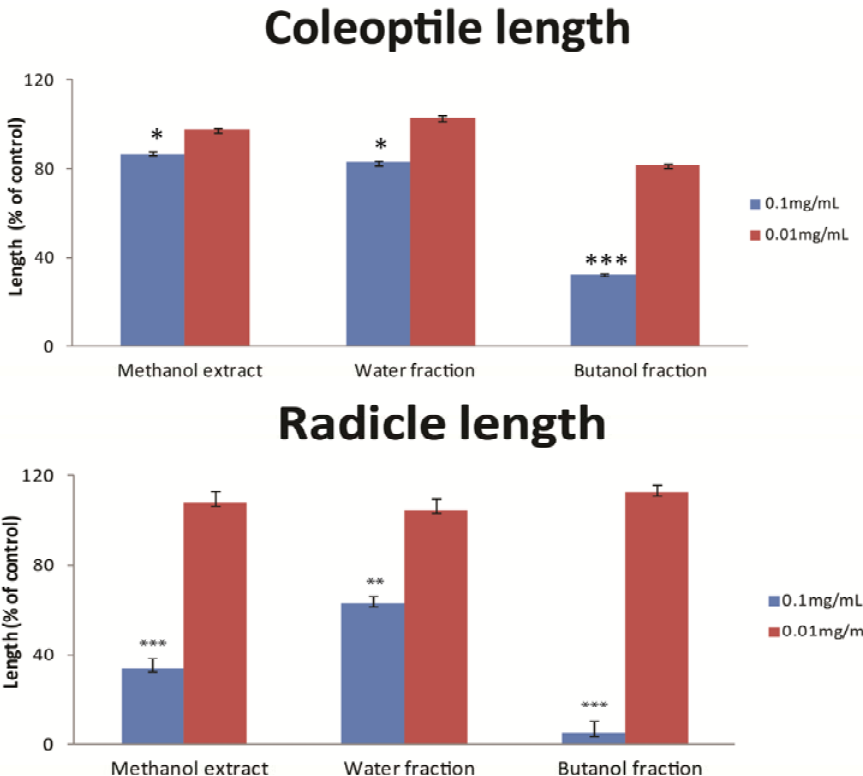
Figure 3. The effect of water and butanol fractions of a methanol extract of Amaryllis belladonna on coleoptile and radicle length of Senecio vulgaris seeds at concentrations of 0.1 and 0.01mg/mL. Effects are expressed as coleoptile or radicle length of the treatment as a percentage of the corresponding length of coleoptile or radicle length of the control. Data present means and standard deviations of three replicates. Significant differences between control and treatment are indicated as * p ≤ 0.05, ** p ≤ 0.01 and *** p ≤